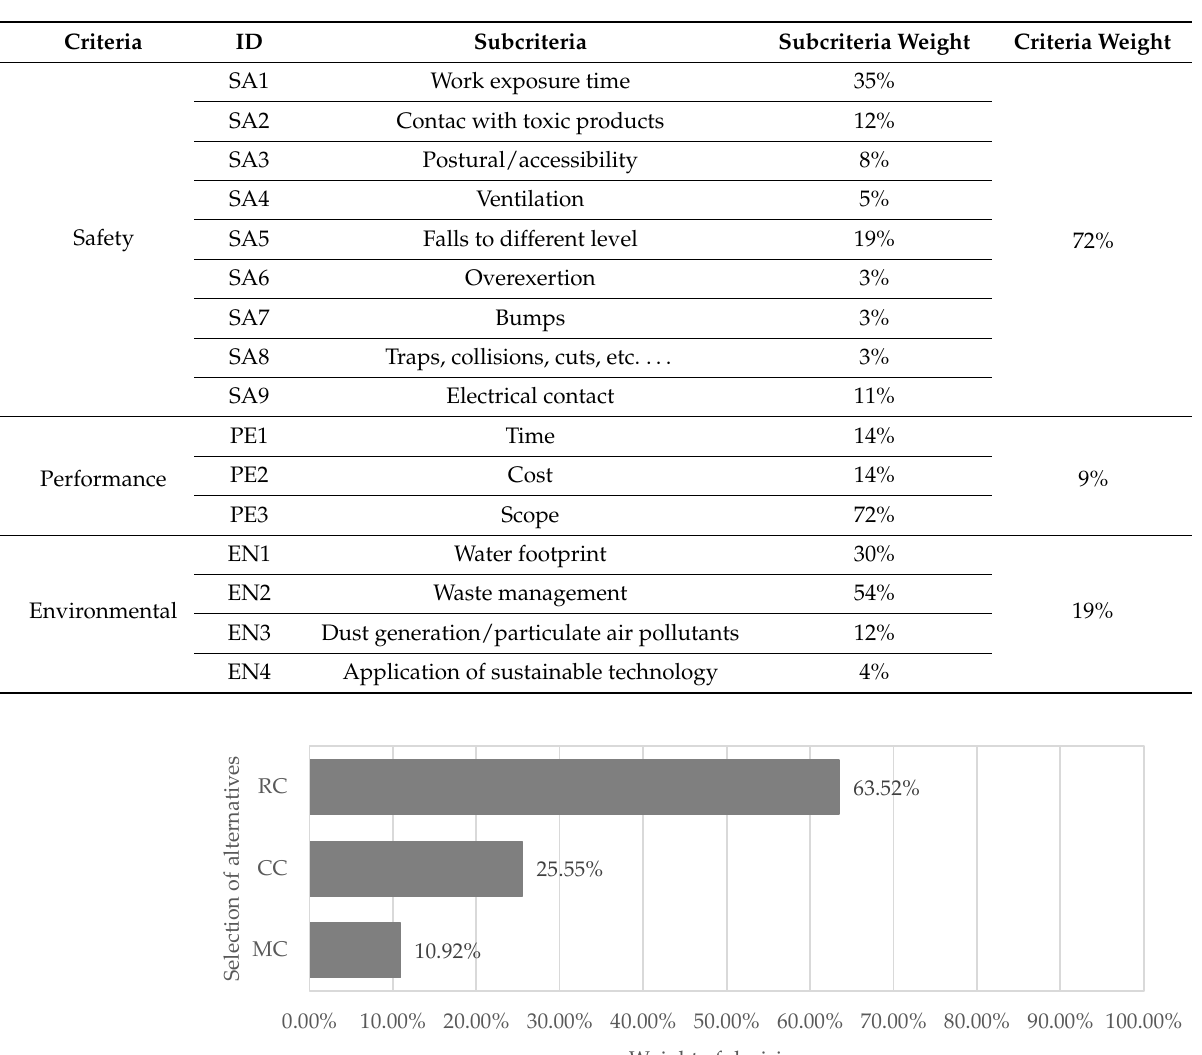
Table 7. Criteria and subcriteria local weighting summary.